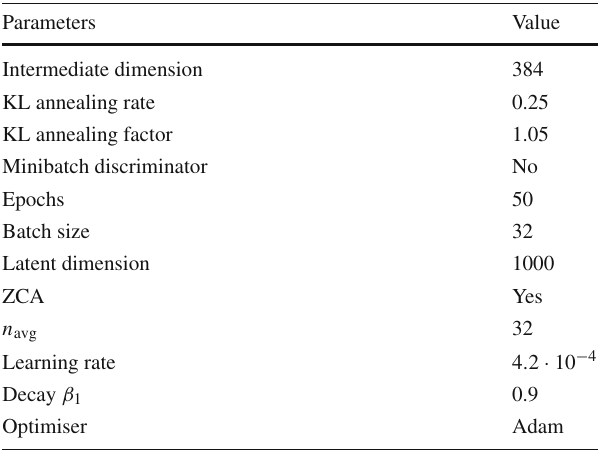
Table 3 Final parameters for the VAE